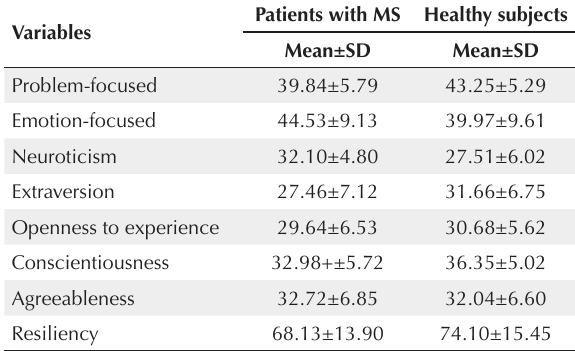
Table 2. Mean ± SD for research variables Variables